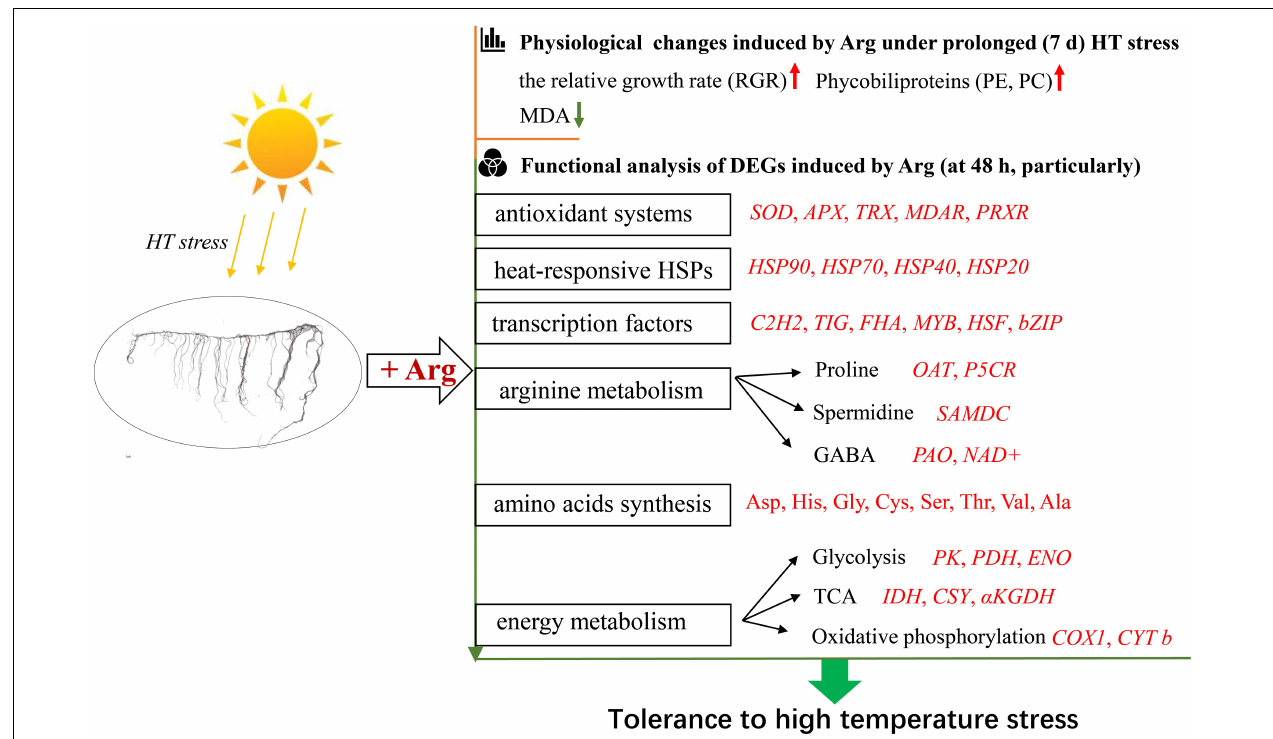
FIGURE 9 | A proposed model for Arg-induced HT tolerance in G. lemaneiformis associated with physiological and transcriptional changes of Gracilaria lemaneiformis under HT stress. The red font indicates upregulation, green font means downregulation. HT, high temperature; PE, phycoerythrin; PC, phycocyanin; MDA, malondialdehyde; SOD, superoxide dismutase; APX, ascorbate peroxidase; TRX, thioredoxin; MDAR, monodehydroascorbate reductase; PRXR, peroxiredoxins; OAT, ornithine–oxo-acid transaminase; P5CR, pyrroline-5-carboxylate reductase; SAMDC, S-adenosylmethionine decarboxylase; GABA, γ -aminobutyric acid; PAO, polyamine oxidases; NAD+, aldehyde dehydrogenase; Asp, aspartate; His, histidine; Gly, glycine; Cys, cystine; Ser, serine; Thr, threonine; Val, valine; Ala, Alanine; PK, pyruvate kinase; PDH, pyruvate dehydrogenase; ENO, enolase; TCA, tricarboxylic acid; IDH, isocitrate dehydrogenase; CSY, citrate synthase; α KGDH, 2-oxoglutarate